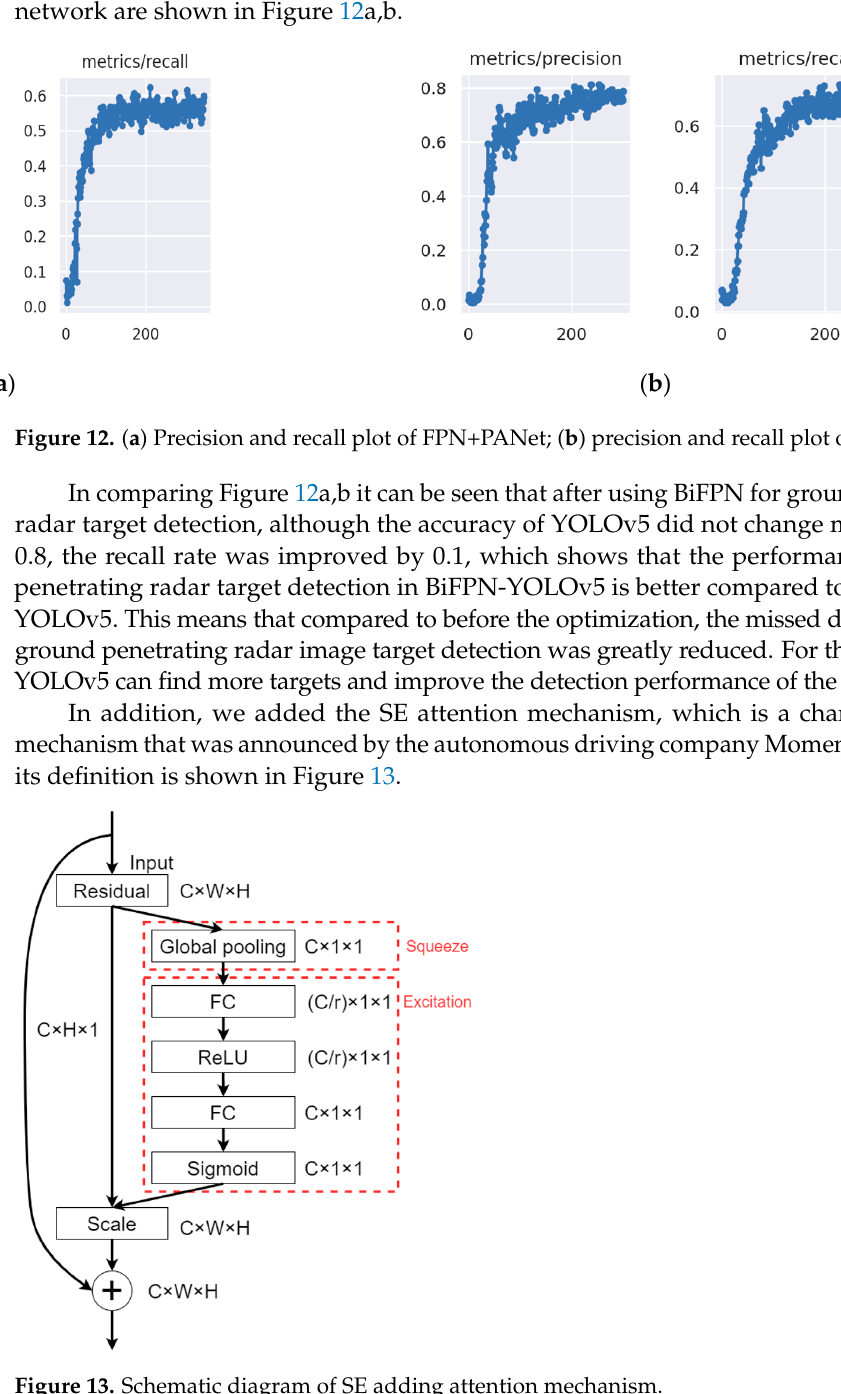
( b ) Figure 11. ( a ) Schematic diagram of PANet network; ( b ) schematic diagram of BiFPN network. In this study, BiFPN was used to replace the FPN + PANet network [34] of the origi- nal YOLOv5, which improved its ability in multi-scale target recognition and the recogni- tion rate of small targets in GPR images without increasing the computational cost [35]. BiFPN uses a fast normalized fusion algorithm, which gives different weights to the fea- tures of each layer for fusion so that the network pays more attention to important layers and reduces the node connections of some unnecessary layers. In addition, when the input and output nodes are of the same scale, BiFPN adds an additional input channel to fuse more features without increasing the computational cost, as shown in Figure 11b. The fast normalized fusion algorithm is as follows: